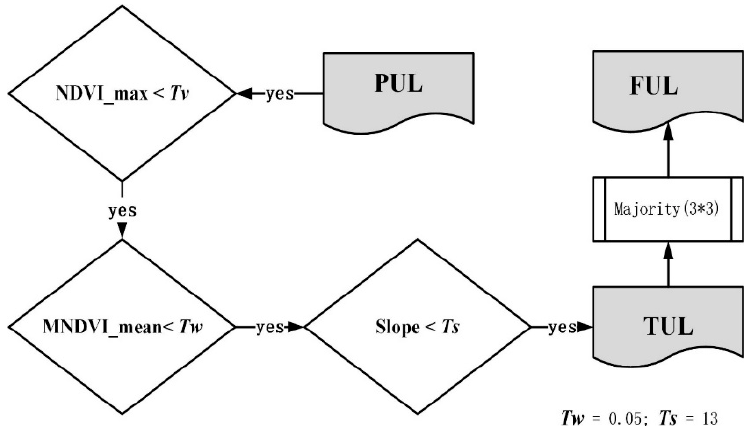
Figure 5. The flow chart for converting the PUL to FUL. PUL: potential urban land; TUL: target urban land; FUL: final urban